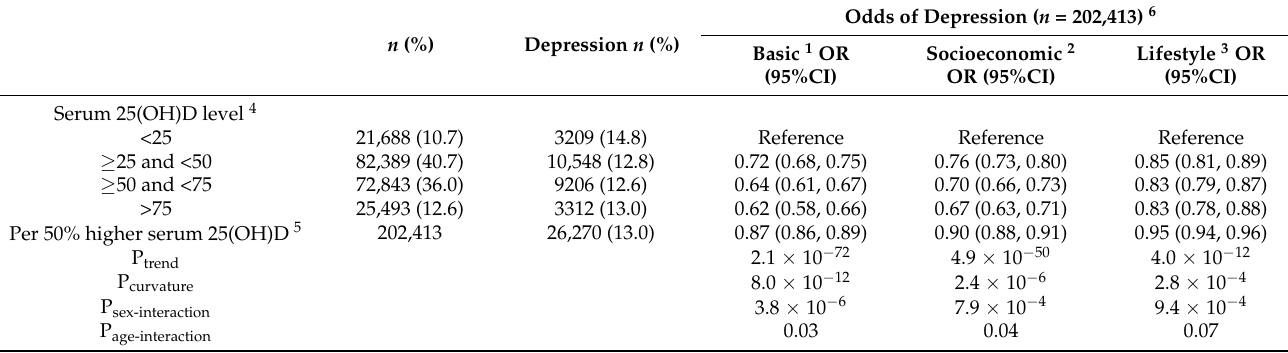
Table 2. Association between serum 25(OH)D and